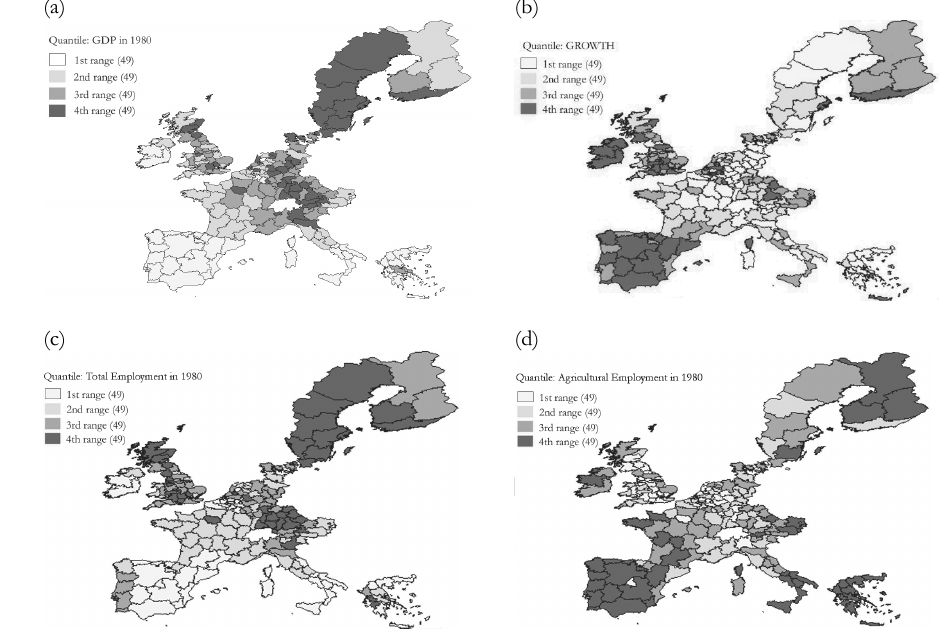
Figure 1 – Spatial percentile distribution for the log of per capita GDP in 1980 with deviations with respect to the EU-15 mean (a), the growth of per capita GDP between 1980 and 2006 (b), the total employment in 1980 (c), the share of agricultural employment in 1980